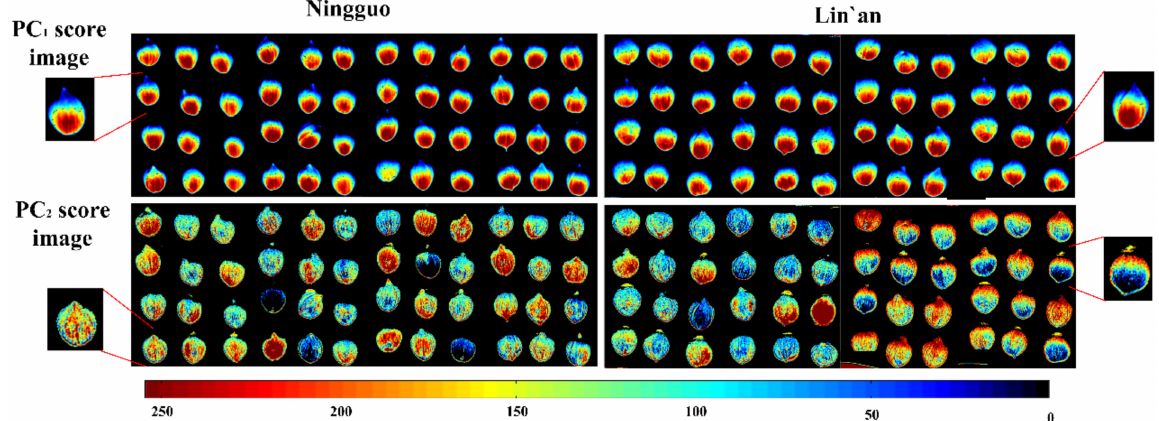
Figure 3. First two PC score images of Ningguo and Lin’an Chinese walnuts. PC: principal component; PC 1 : first principal component; PC 2 : second principal